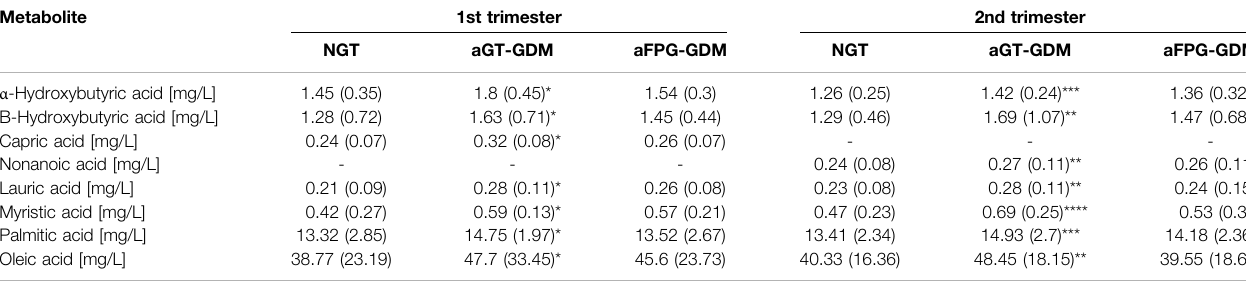
TABLE 2 | Statistically signi fi cant metabolites for NGT vs aGT-GDM comparison based on the validation study results. Metabolite 1st